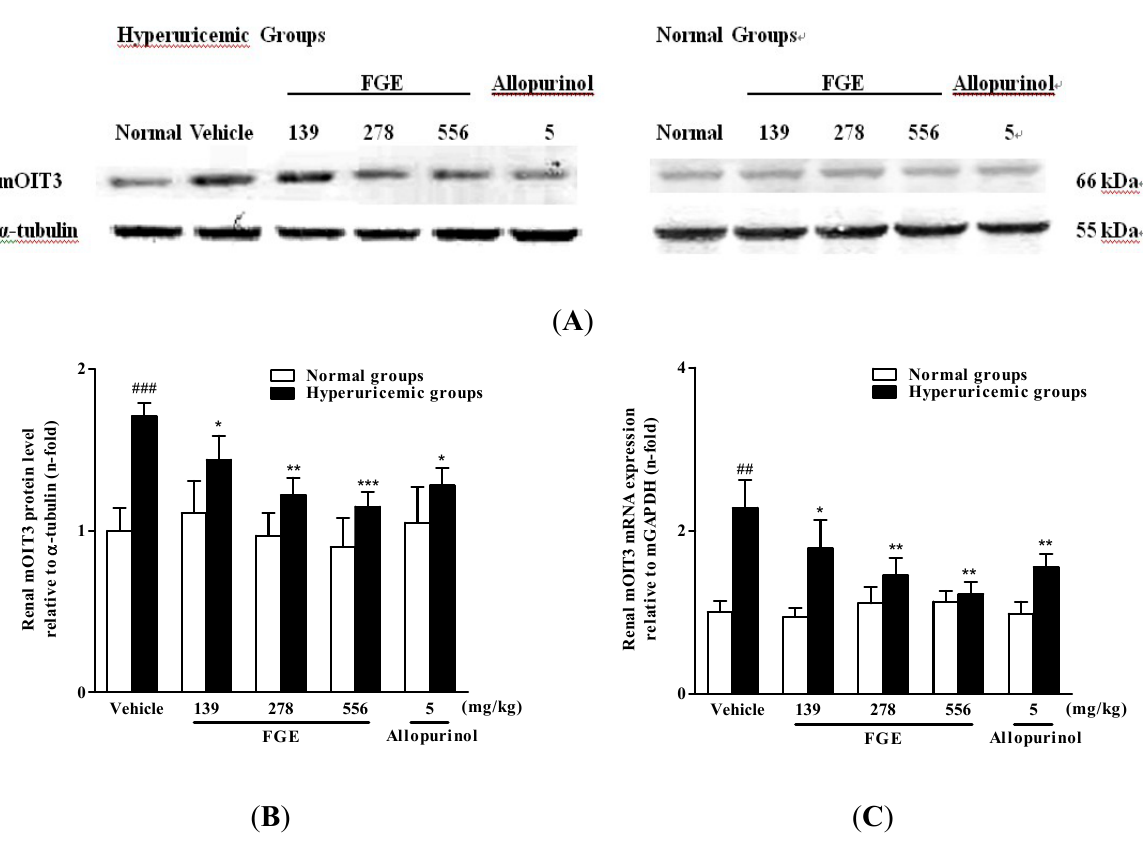
Figure 2. Effects of FGE and allopurinol on mRNA and protein levels of mOIT3, as well as THP levels in kidney and urine in hyperuricemic and normal mice. Kidney cortex tissues were used for western blot analysis of mOIT3 ( A ). The ratio of mOIT3 ( B ) density to α -tubulin density. Kidney cortex mRNA was extracted for RT-PCR analysis of mOIT3 ( C ) and THP ( D ). Data were expressed as the mean ± S.E.M. for four mice. THP levels in kidney ( E ) and urine ( F ) were detected by ELISA kits. Data were expressed as the mean ± S.E.M. for 8 mice. ## p < 0.01, ### p < 0.001, compared with normal vehicle animals. * p <